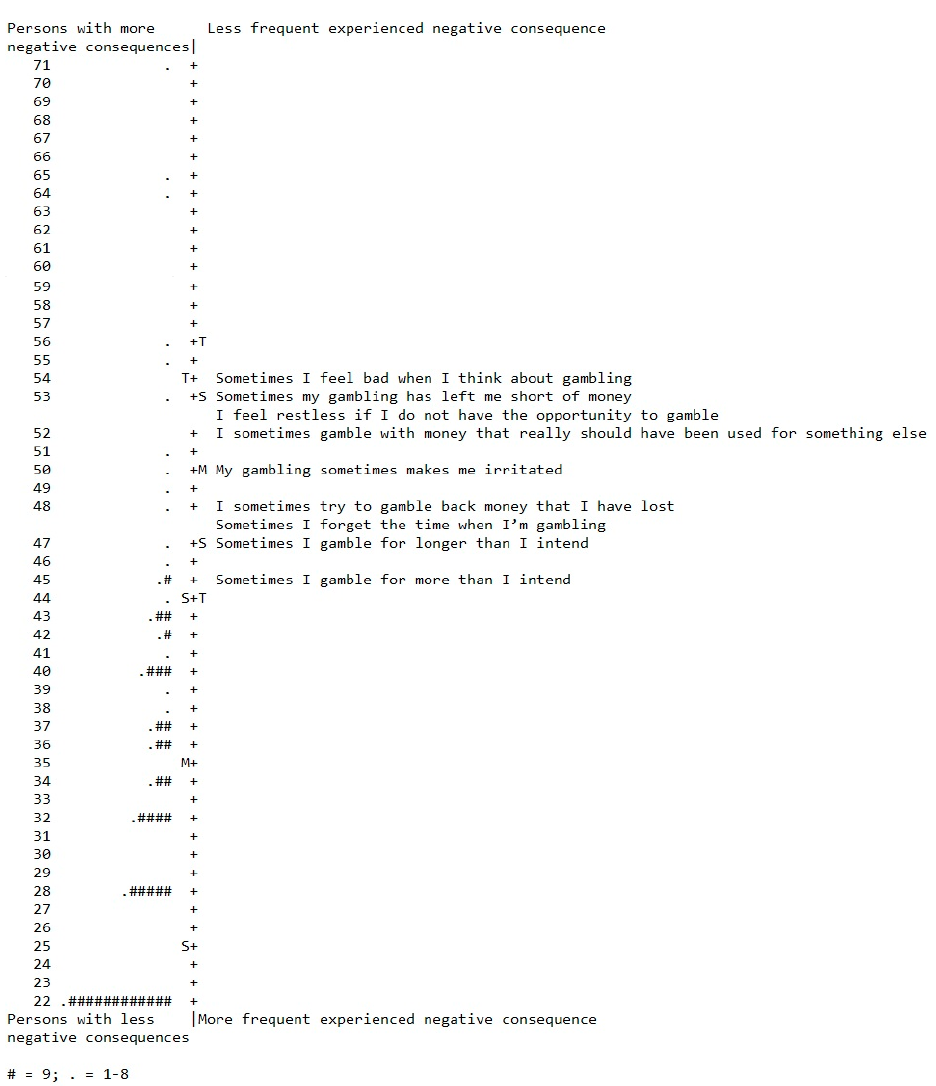
Figure 1. Item–person map for the final scale of the GamTest (nine items).